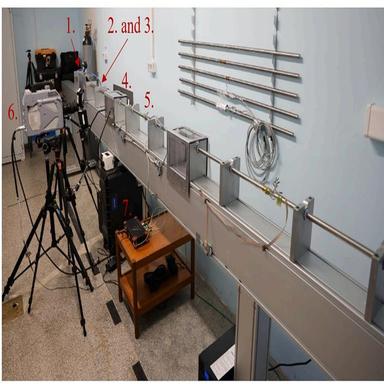
DIHB testing device and set-up.